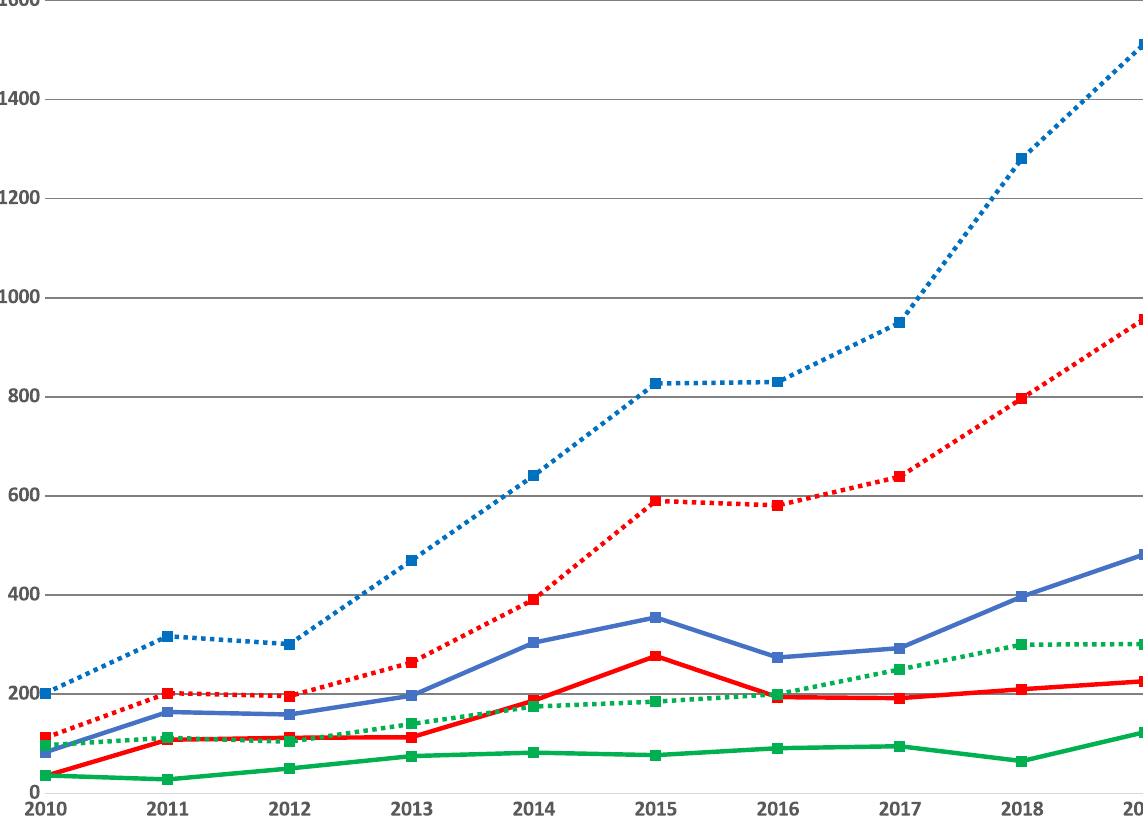
Figure 1. The following graphs show the manuscripts received (in blue), rejected (in red), and published (in green) by the Annals of the Brazilian Academy of Sciences (AABC) between 2010 and 2019. The dotted lines represent published articles from all areas (including Biological Sciences), while solid lines represent Biological Sciences